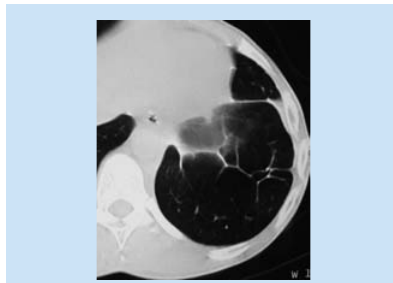
Fig. 21b. Lymphangitis